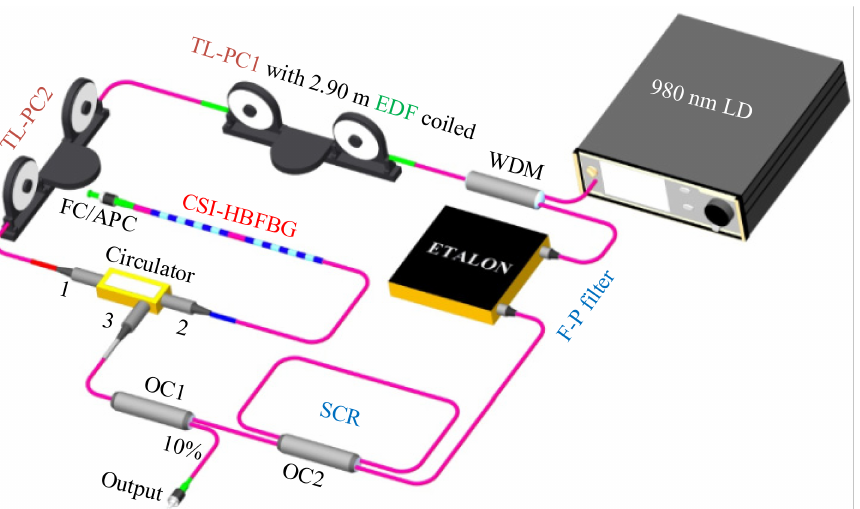
Figure 1. Schematic of the proposed 8WS-EDFL. LD: laser diode; WDM: wavelength division multi- plexer; EDF: erbium-doped fiber; TL-PC: three-loop polarization controller; CSI-HBFBG: cascaded superimposed high-birefringence fiber Bragg grating; OC: optical coupler; SCR: single coupler ring; F-P filter: Fabry–P é rot